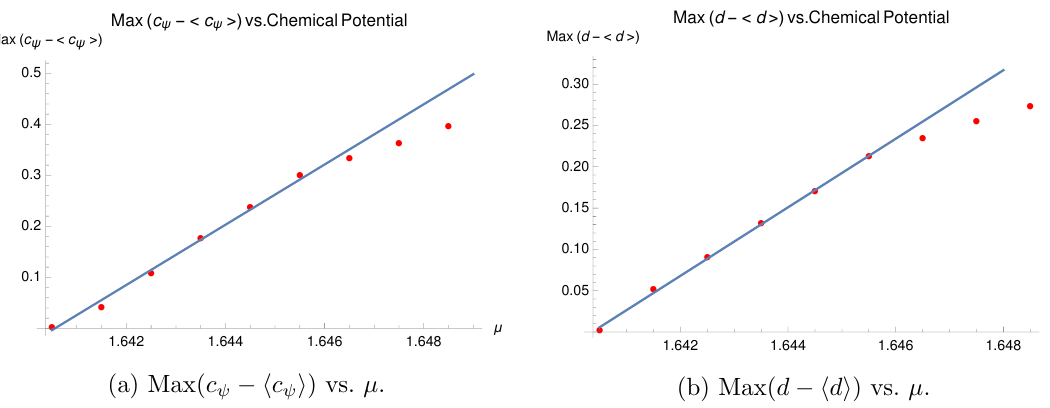
(a) Free energy density F=L vs. (cid:22) . The transi- tion occurs at (cid:22) c = 1 : 6405. Figure 4 . Plot of Free energy density F=L and charge density (cid:26) vs. (cid:22) .